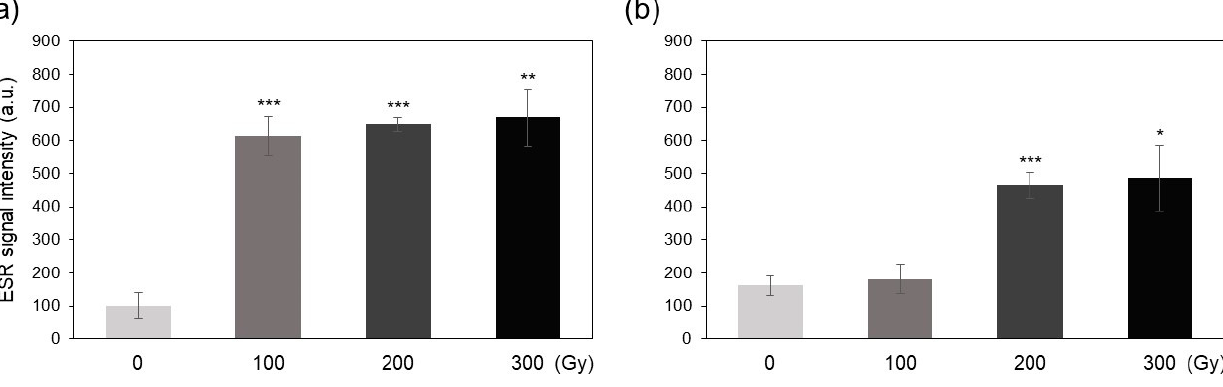
Figure 2. Determination of the free radical content of gamma-irradiated rice plants using the electron spin resonance (ESR) method. ( a , b ) ESR intensity in rice plants subjected to acute ( a ) and chronic ( b ) gamma irradiation. Data represent mean ± SD. Asterisks indicate significant differences between control (0 Gy) and other treatments (* p < 0.05, ** p < 0.01, *** p < 0.001).